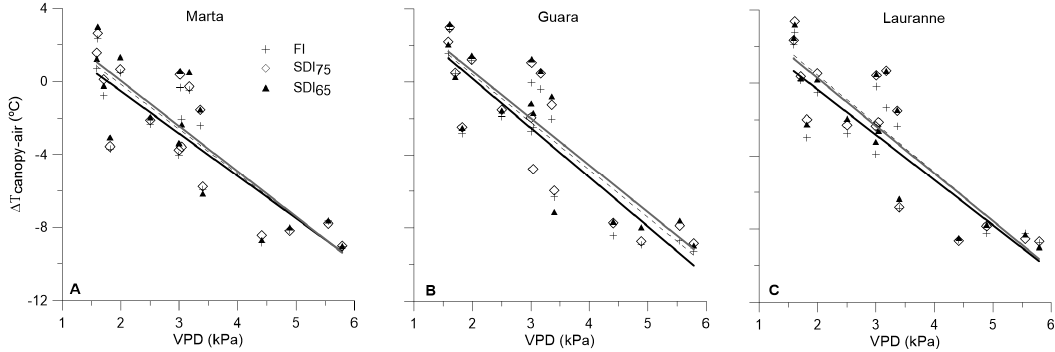
Figure 3. Water-stress baselines for cvs. Marta ( A ), Guara ( B ), and Lauranne ( C ). Black continuous, discontinuous and grey lines are the regressions functions that represent the non-water-stress baseline for fully irrigated (FI), and the water-stress baselines for sustained deficit irrigation at 75% of the crop irrigation requirements (SDI 75 ) and sustained deficit irrigation at 65% of the crop irrigation requirements (SDI 65 ), respectively. Table 5. Fitted parameters for the non-water-stress baselines and water-stress baselines for the almond cultivars and irrigation treatments. cv. Guara cv. Marta Baseline